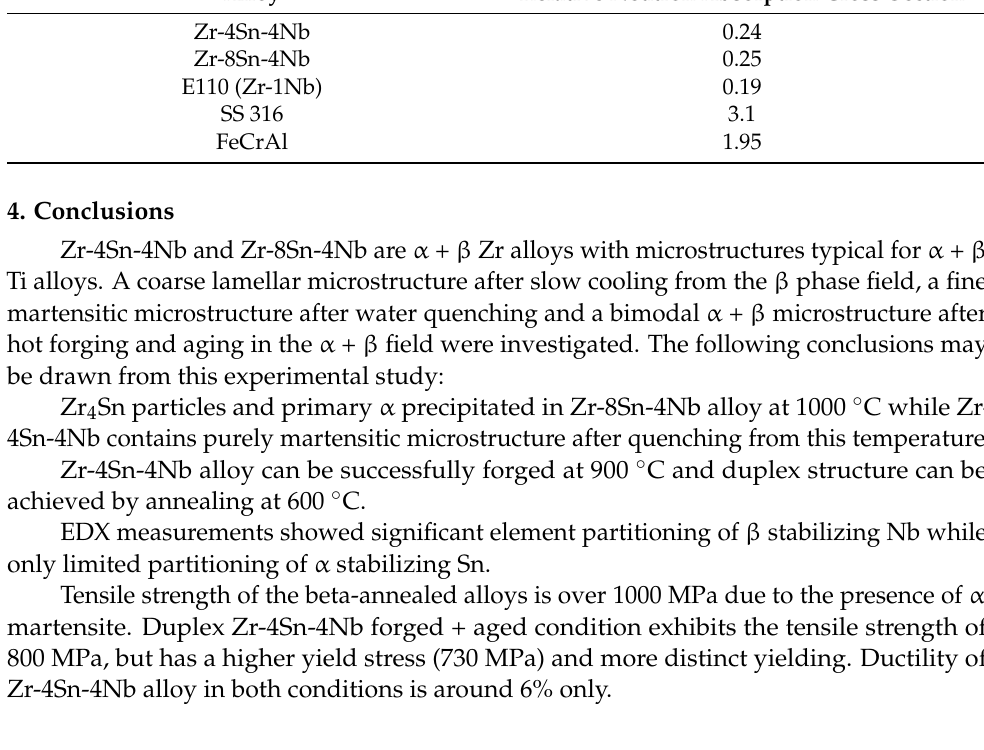
Table 5. Comparison of thermal neutron absorption cross-sections.